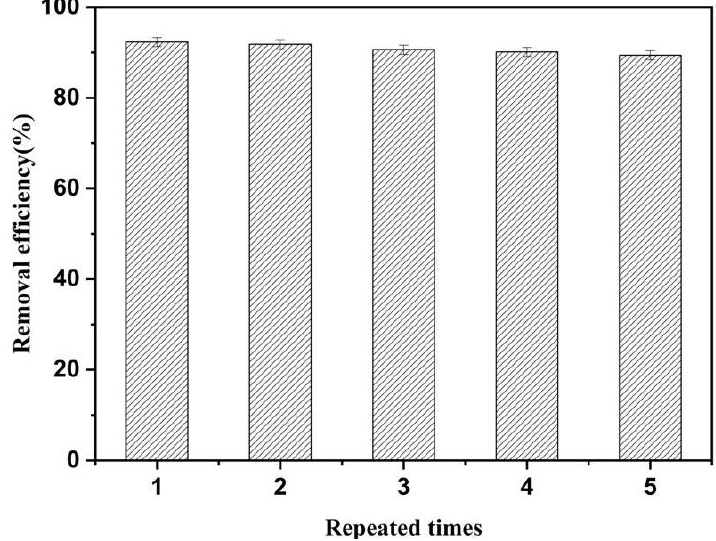
Figure 7. Recyclability of MrGO-2. Reaction conditions: T 0 = 25 °C, C 0, SDZ = 100 μg/L, (MrGO-2) = 0.25 g/L and pH with no adjustment.